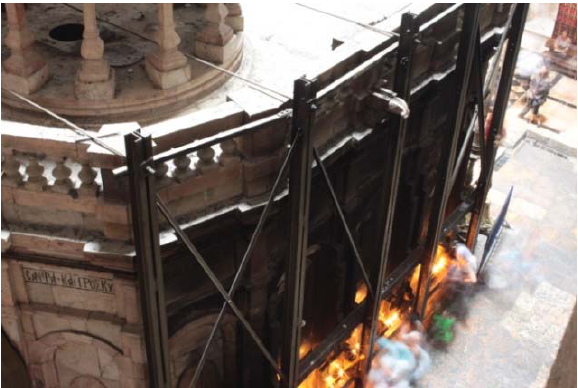
Figure 1: The south façade (2015) of the Holy